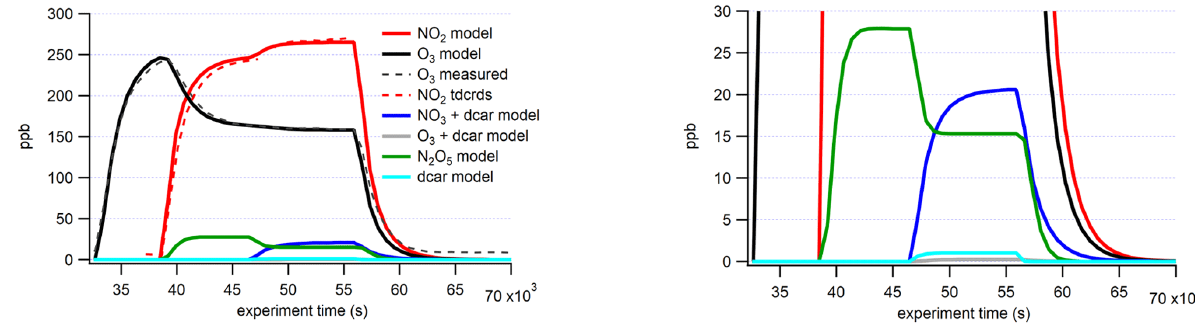
Figure 3. KinSim simulation of the (cid:49) -3-carene + NO 3 experiment. Measured traces are shown with dashed lines, and modeled results are shown with solid lines. Additional modeling of the other MT systems are shown in Fig. S1 in the